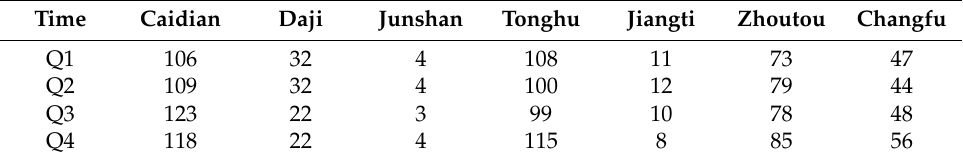
Table 2. Global theft rate rank of Caidian Community and adjoining communities.